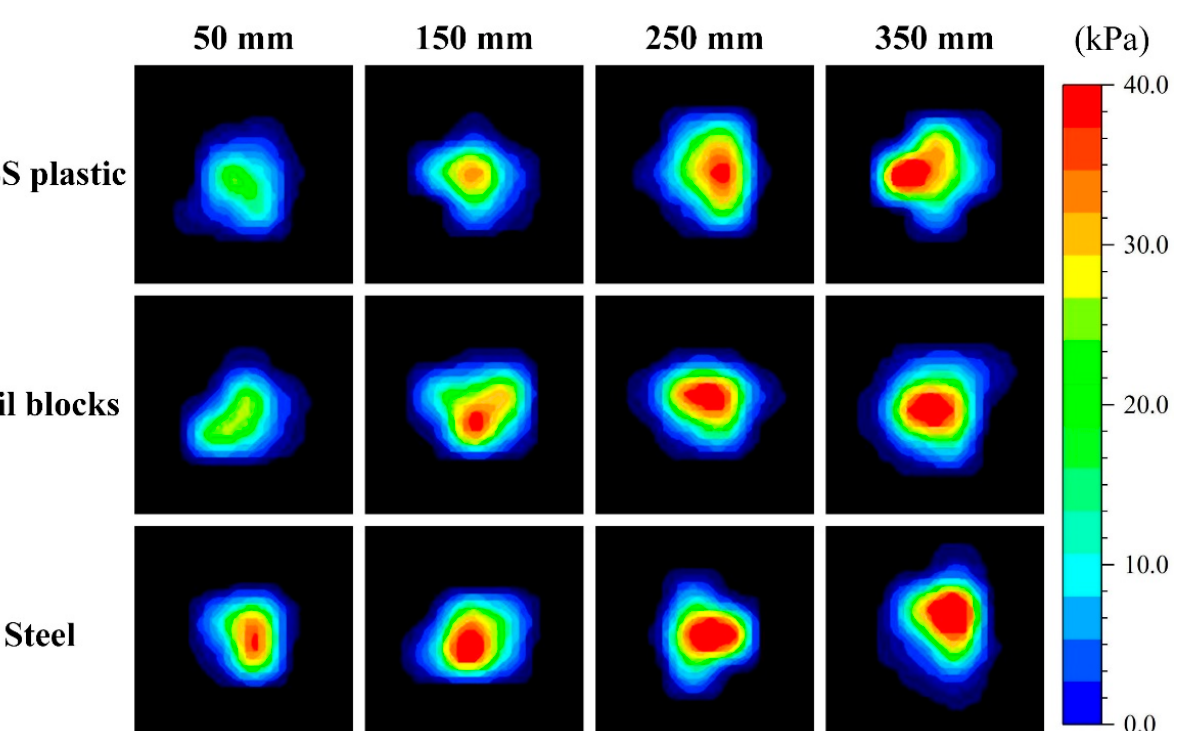
( c ) Figure 8. Pressured area distribution at different drop heights for three collision materials: ( a ) steel, ( b ) soil blocks, and ( c ) ABS plastic. 3.3.2. Seedling Pot Size and Drop Height The collision material was steel. The drop heights of 50 mm, 150 mm, 250 mm, and 350 mm were selected. The small, medium and big sizes of the seedling pot were selected. The results of the single-factor test are shown in Figure 9. The DSP of the seedling pot of big, medium, and small sizes decreased sequentially. The main reason for this was that when the seedling age was 25 days, the roots of seedlings with a big pot size were not sufficiently twined with the substrate, which reduced the damage resistance of the